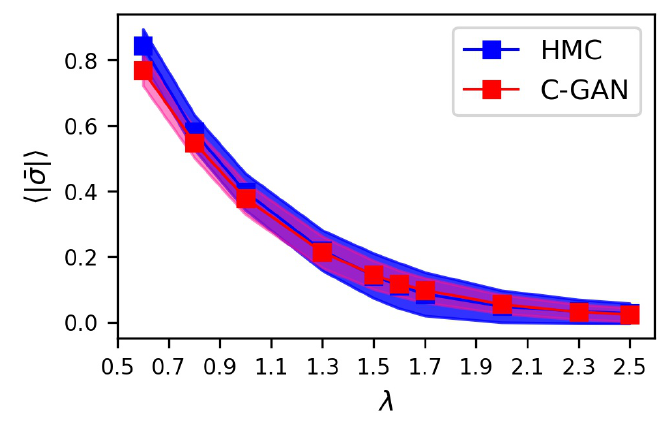
Figure 20: Ablation for periodic padding: Mean 〈| ¯ σ |〉 and standard deviation on Λ set without periodic padding in both generator and discriminator.